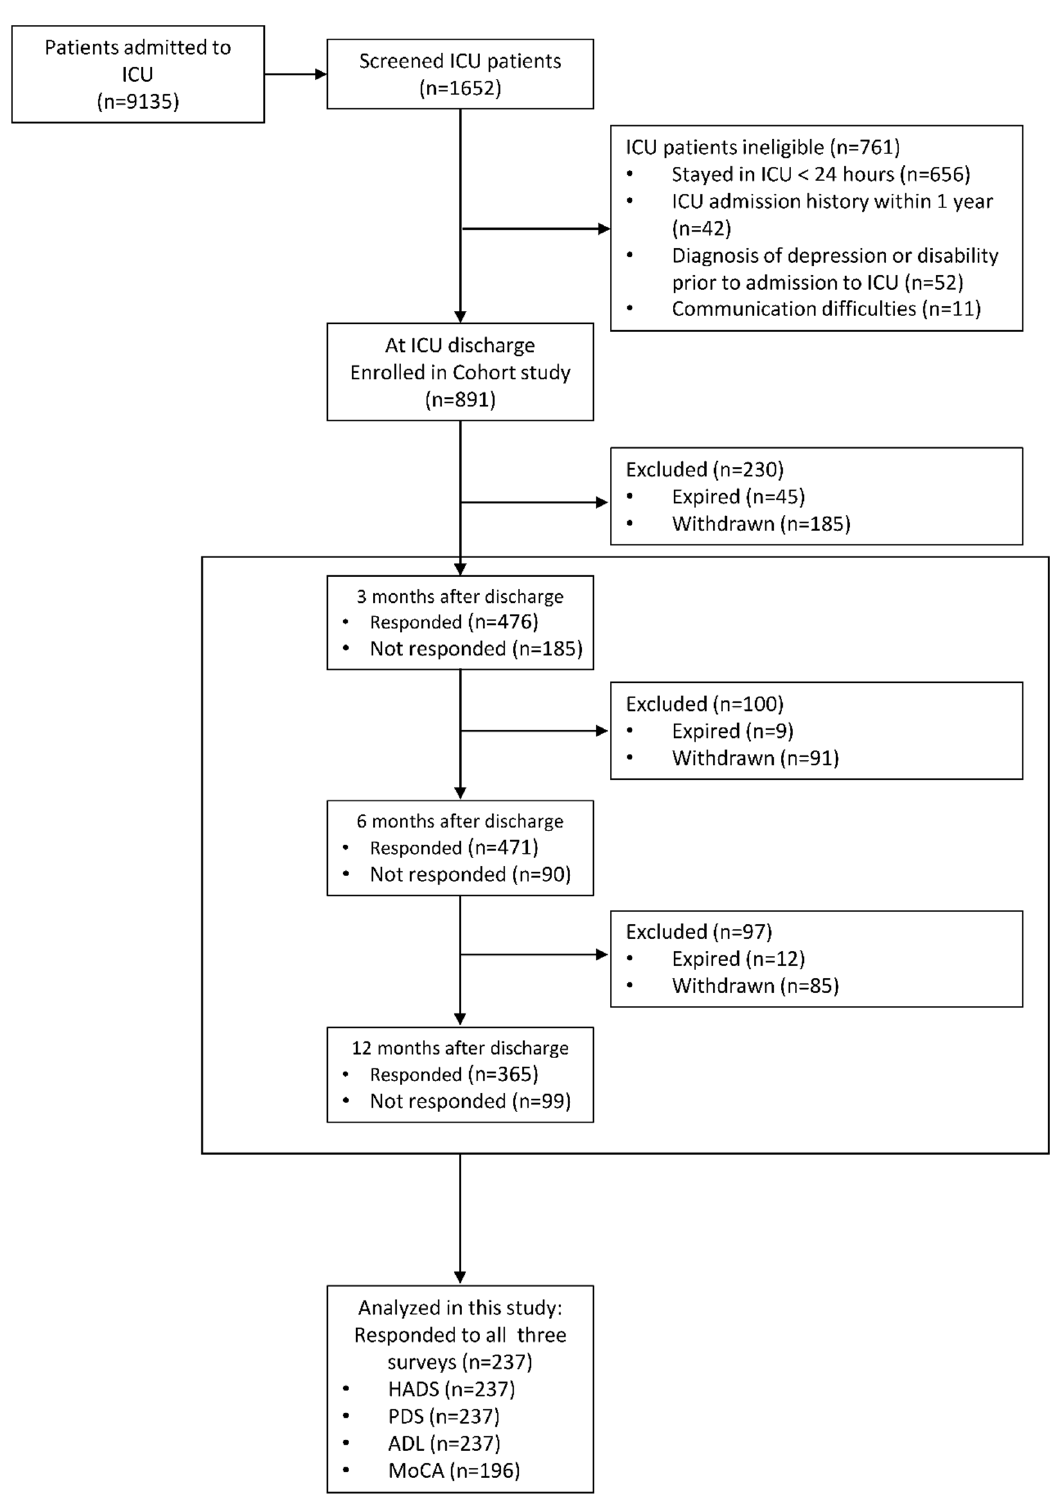
Figure 1. Flow diagram of study participants. Abbreviations: ADL: Activities of Daily Living; HADS: Hospital Anxiety and Depression Scale; ICU: intensive care unit; MoCA: Montreal Cognitive Assessment; PDS: Post-traumatic Diagnosis Scale.